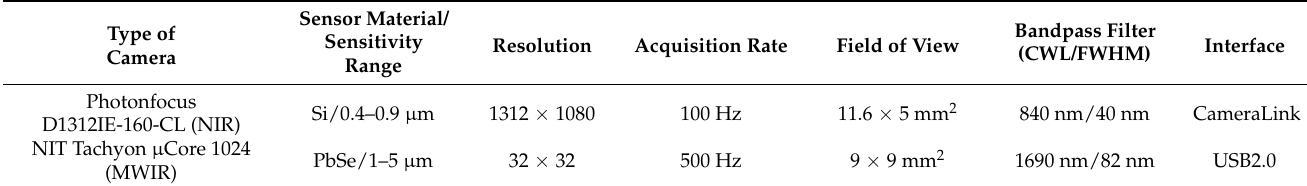
Table 1. Description of the sensors and optical components used for the welding experiments.